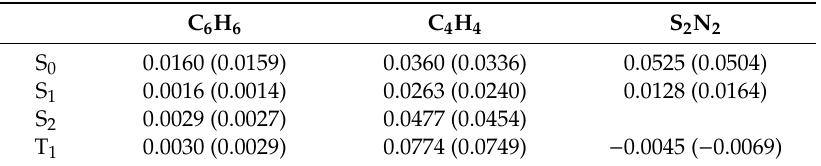
Table 4. 6-centre MCIs for the S 0 , S 1 , S 2 and T 1 states of C 6 H 6 , 4-centre MCIs for the S 0 , S 1 , S 2 and T 1 states of square C 4 H 4 and 4-centre MCIs for the S 0 , S 1 and T 1 states of S 2 N 2 . QTAIM / 6-311 ++ G(2d,2p) for C 6 H 6 and C 4 H 4 ; QTAIM / cc-pVTZ for S 2 N 2 . Values in brackets show the π -only (C 6 H 6 and C 4 H 4 ) and π -only valence (S 2 N 2 ) components of the total